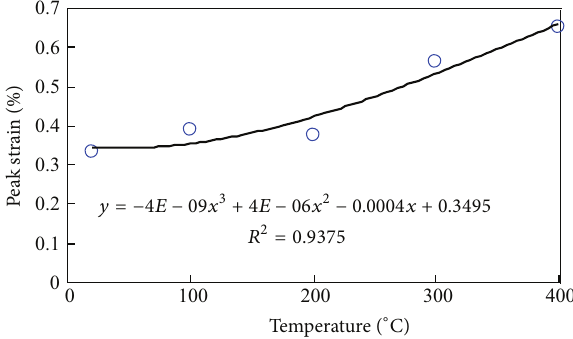
Figure 5: Peak strain variation curve with temperature in granite.